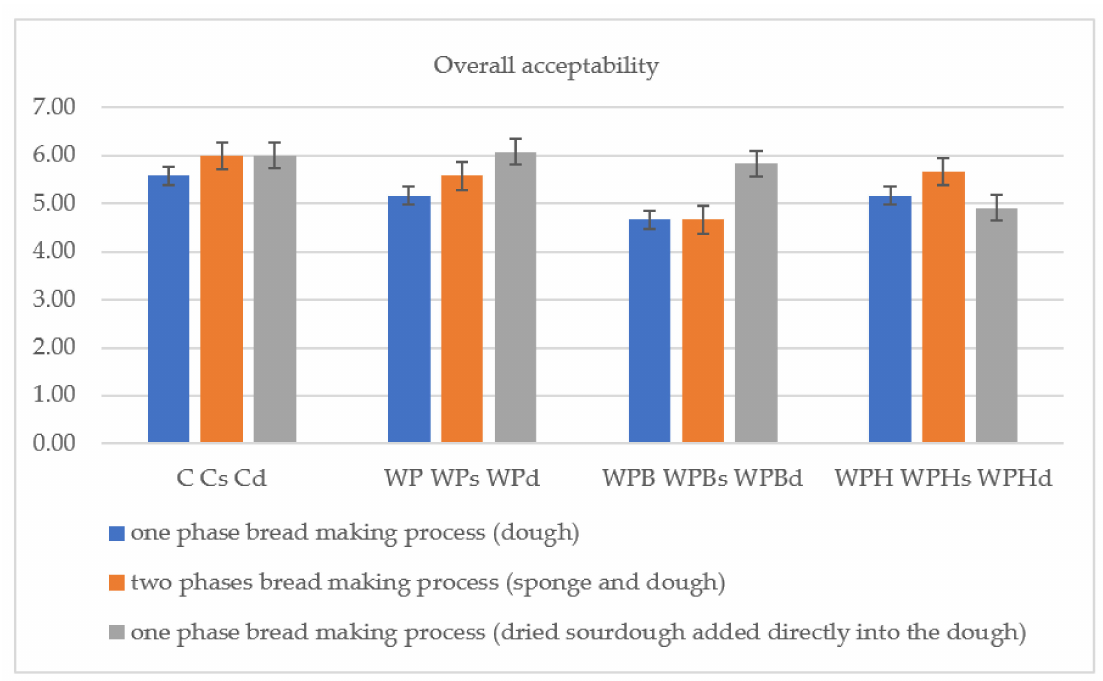
Figure 6. Overall